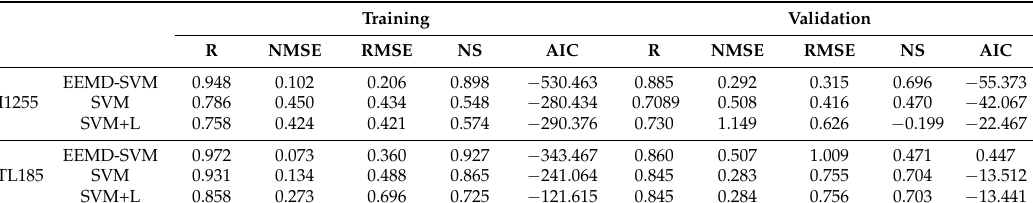
Table 2. Results of modeling from the SVM model at site M1255 and STL185. Training